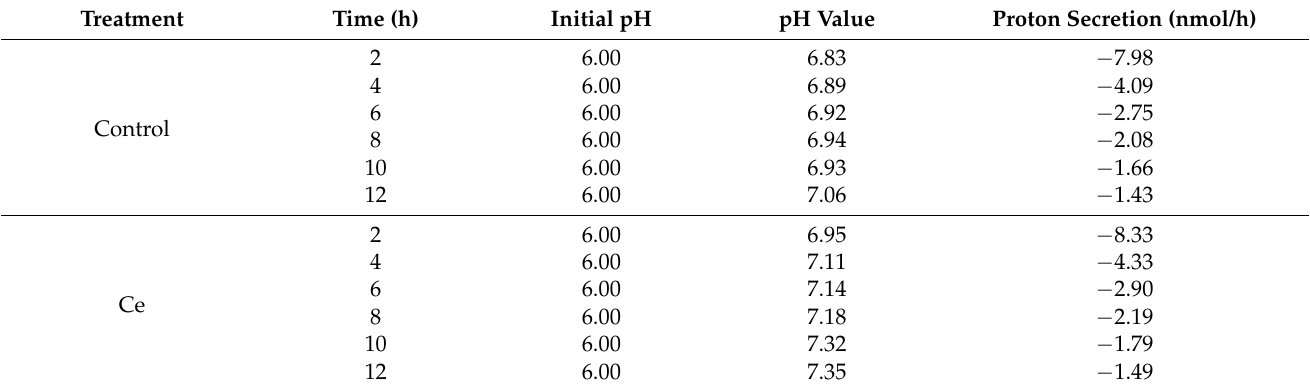
Table 6. Effects of Ce colonization on the pH and amount of protons secreted in the P. vittata rhizosphere.